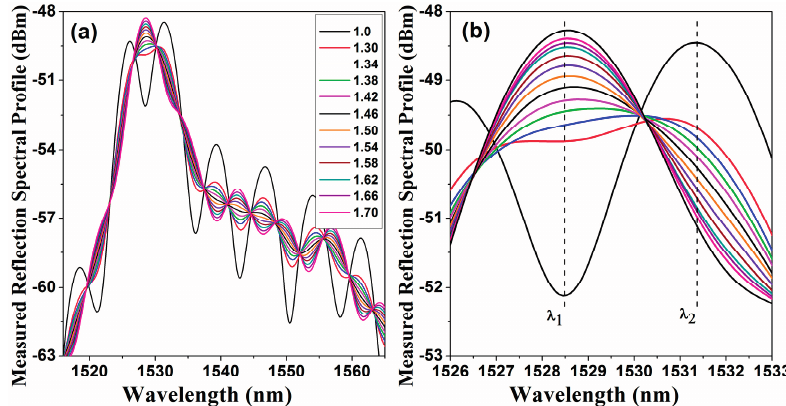
( ) λ , I n for different values of exit M e ( ) λ , I n spectra showing only a single spectral M e